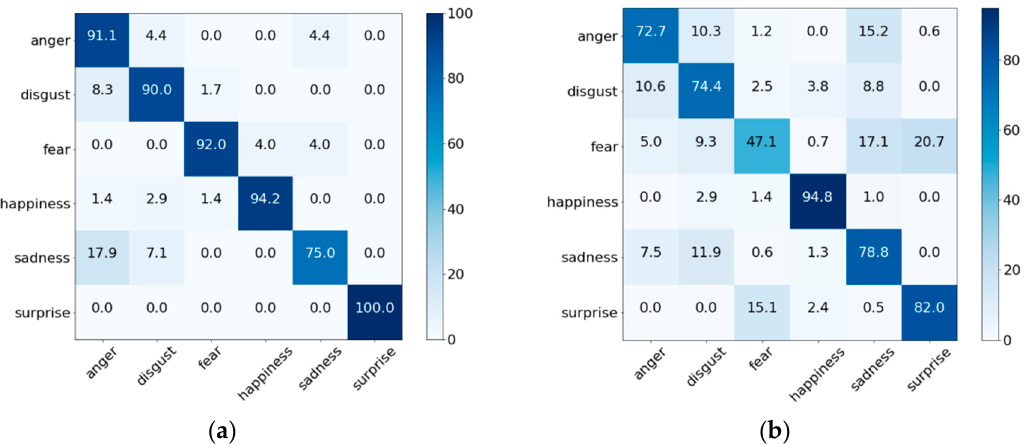
Figure 5. Confusion matrices of the proposed method using different databases (%). ( a ) CK+ database and ( b ) MMI